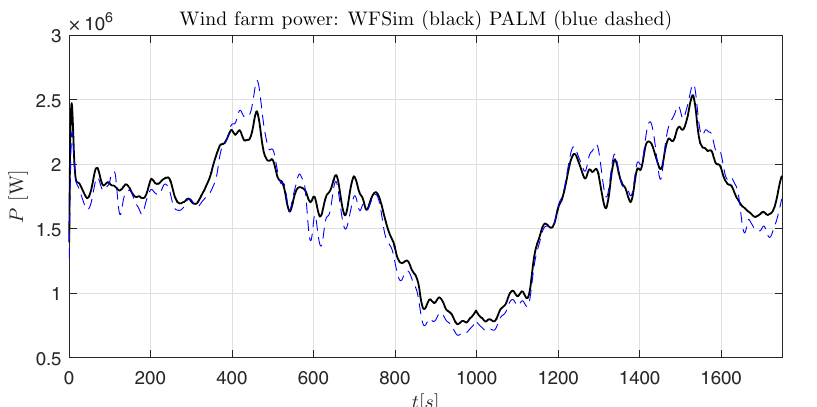
Figure 10. Wind farm power from PALM (blue dashed) and WFSim (black).